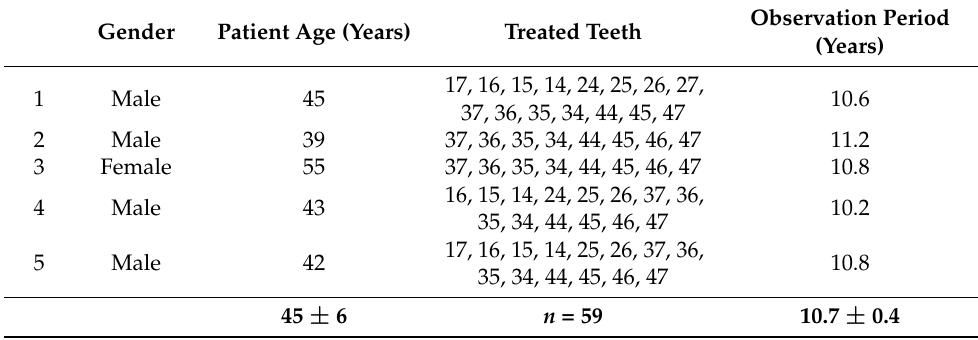
Table 1. Patients and teeth involved (first cohort).